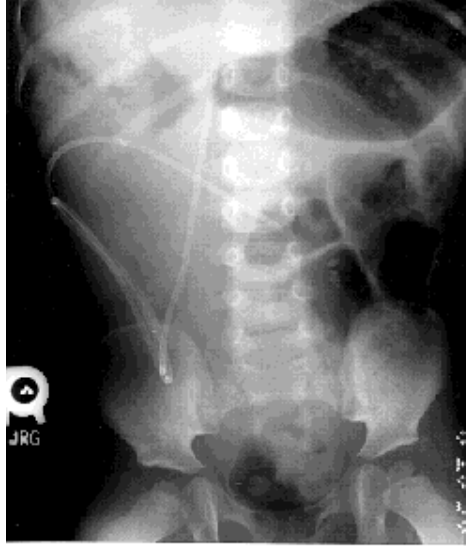
FIGURE 2b . Conventional radiograph after bilateral ESWL showing resolution of calculi. The calcifications seen are located in the retroperitoneum outside the collecting system, as a result stone fragment spillage during the open